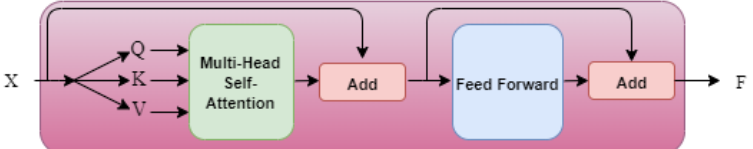
Figure 8. Self-attention blocks (SAB)